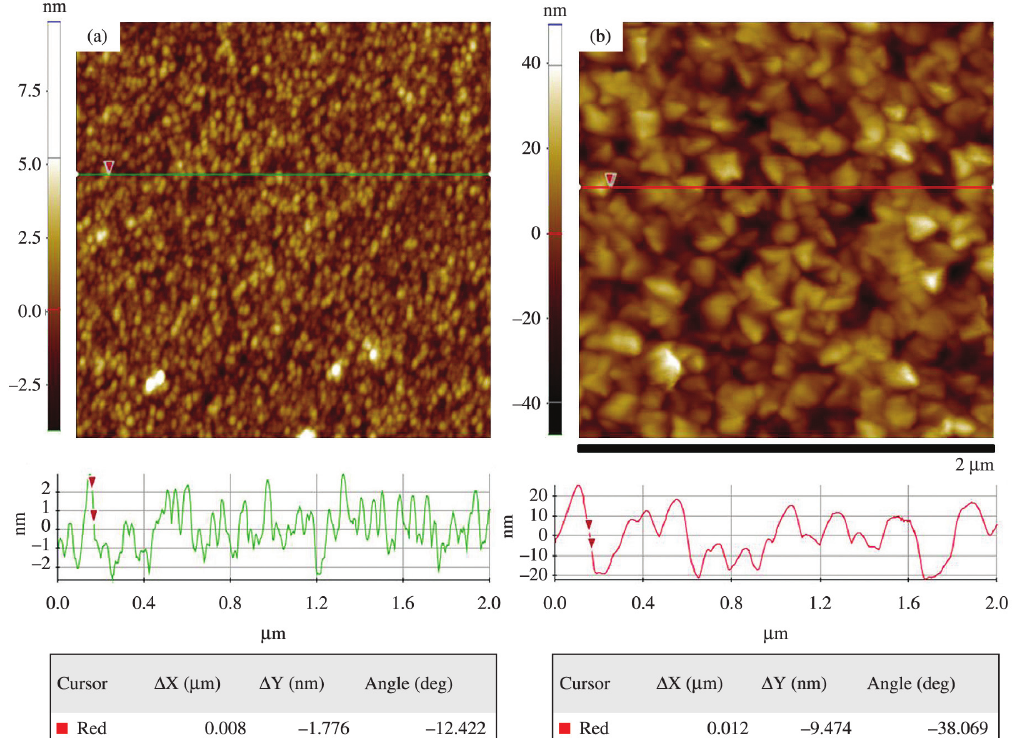
Figure 3. Surface AFM images (2 mm × 2 mm ) and lateral profiles of the ZnO:Al thin films with (a) 50 nm and (b) 250 nm of thickness.